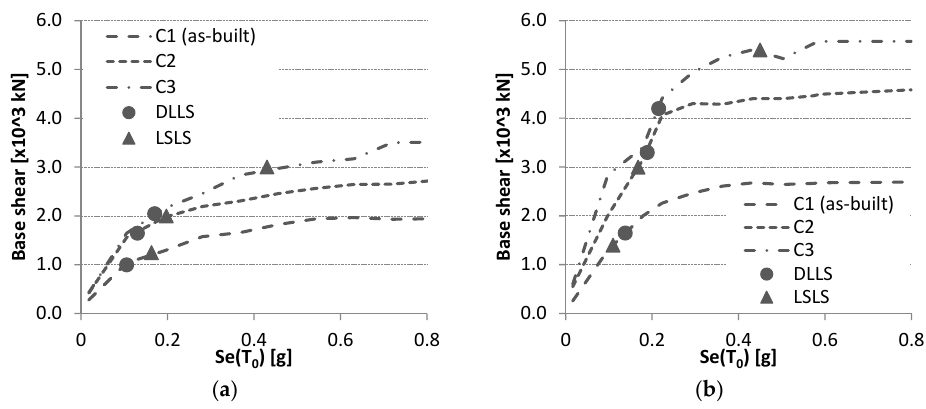
Figure 9. Spectral pseudo-acceleration vs. maximum base shear curves relevant to the three considered configurations, obtained for X ( a ) and Y ( b ) direction by considering median values from IDA analyses.